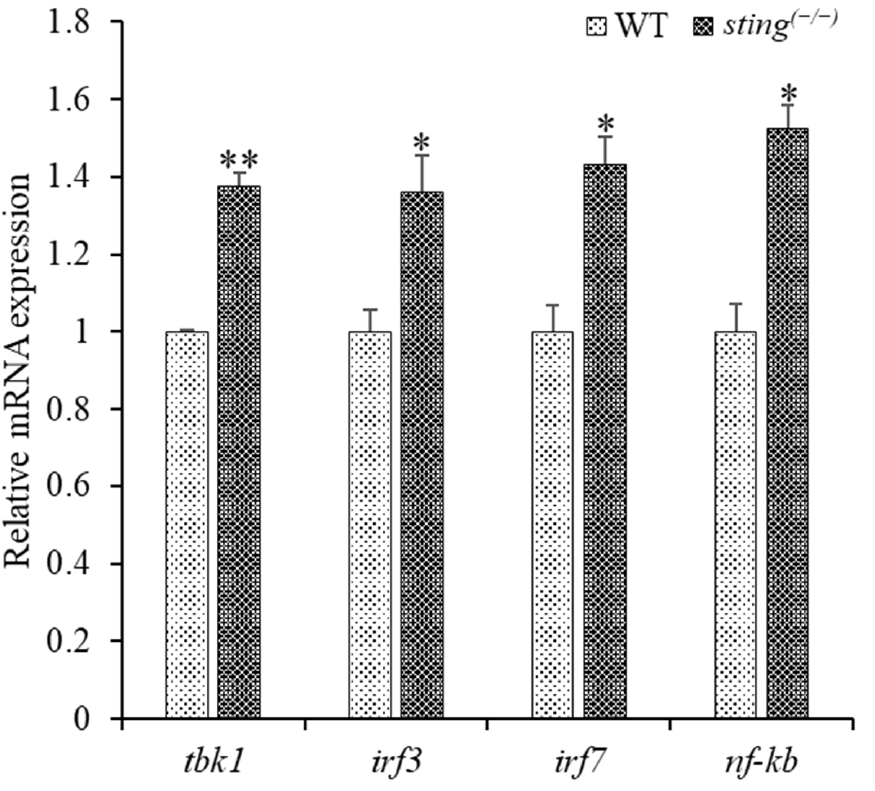
Figure 2. Comparison of transcription of downstream genes in 7 dpf larvae of sting ( − / − ) and WT zebrafish. The internal control gene, β -actin , was used to analyze the relative mRNA expression of genes downstream of sting using the Livak method. Experiments were performed in triplicate, and the error bar represents the standard deviation (SD). Student’s t -tests were used for statistical analysis, and p < 0.01 (indicated by *) and < 0.001 (indicated by **) were considered statistically significant.